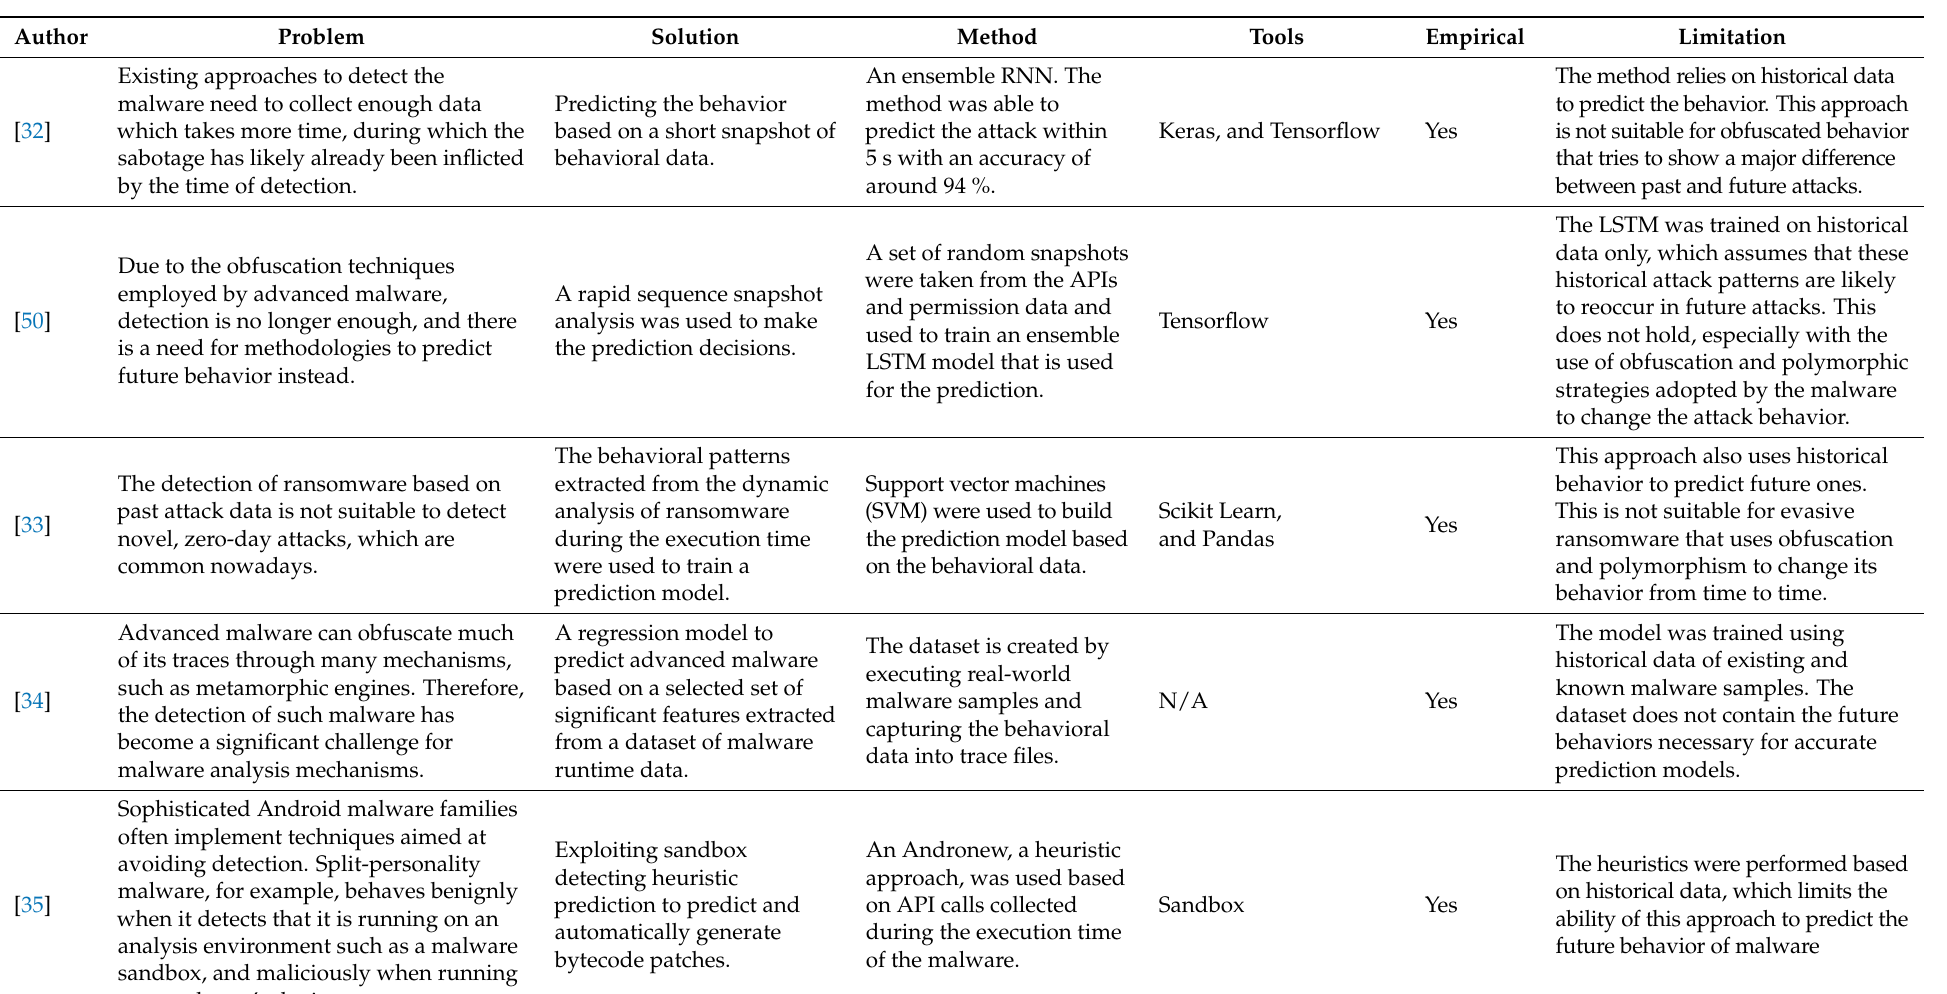
Table 1. Studies related to ransomware behavior